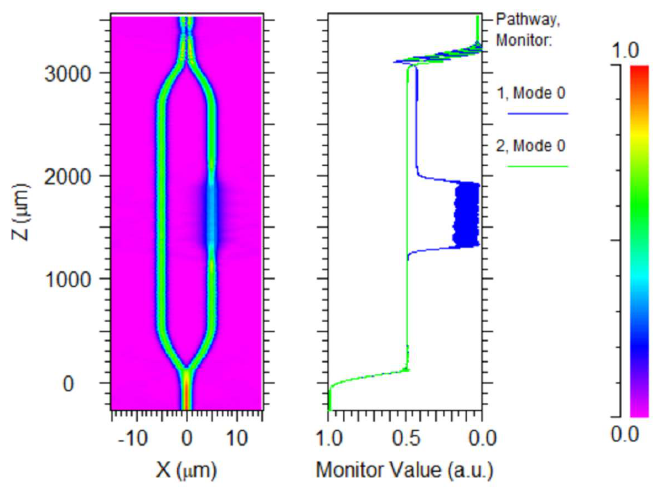
Figure 8. The simulated optical field of the suspended MZI with a slot.